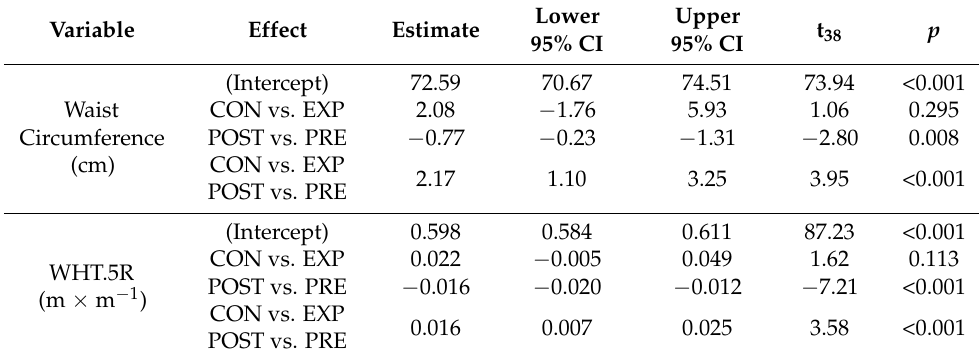
Table 3. Fixed effects of the variables WC and WHT.5R.